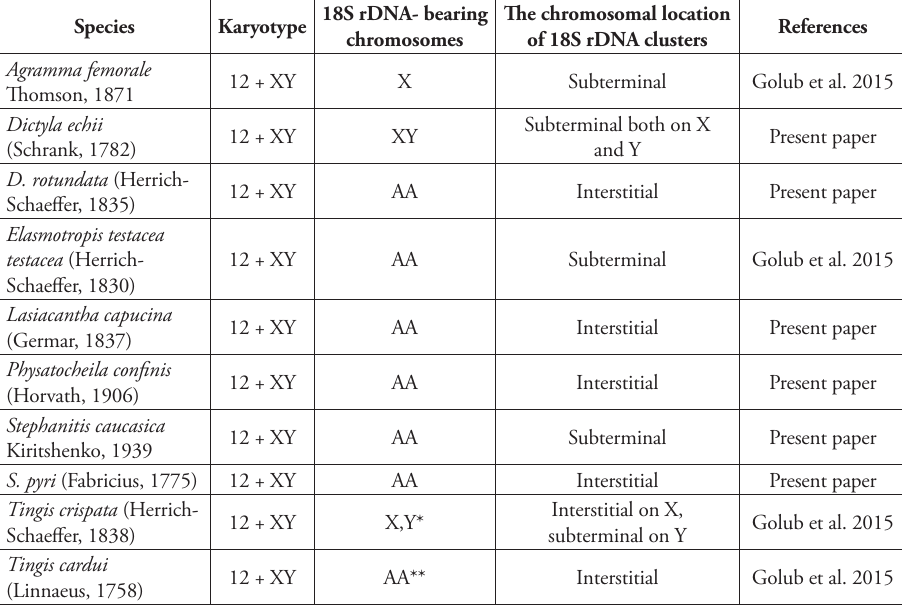
Table 2. Distribution of the major rDNA loci in the Tingidae. 18S rDNA- bearing Species Karyotype